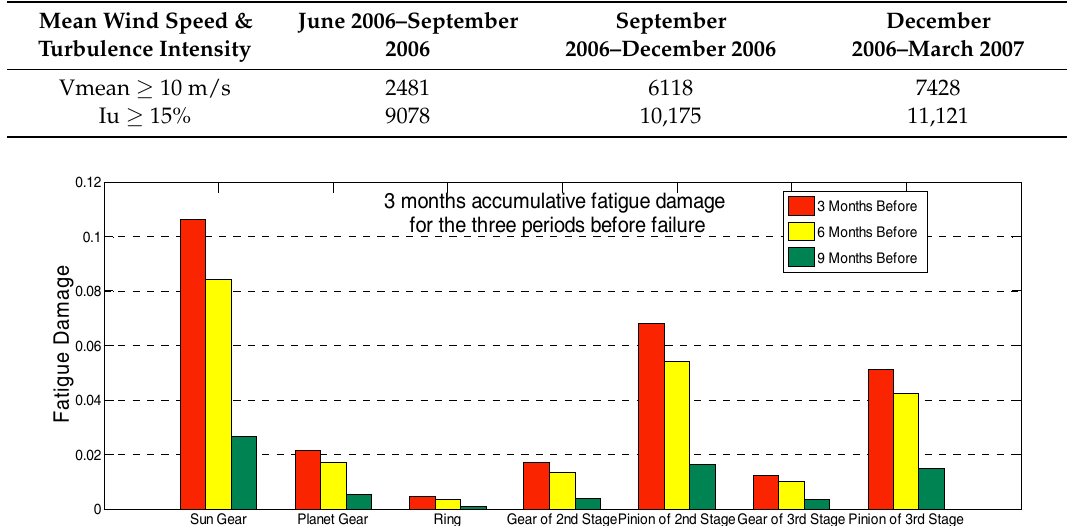
Table 3. Wind speed data of SCADA analysis.